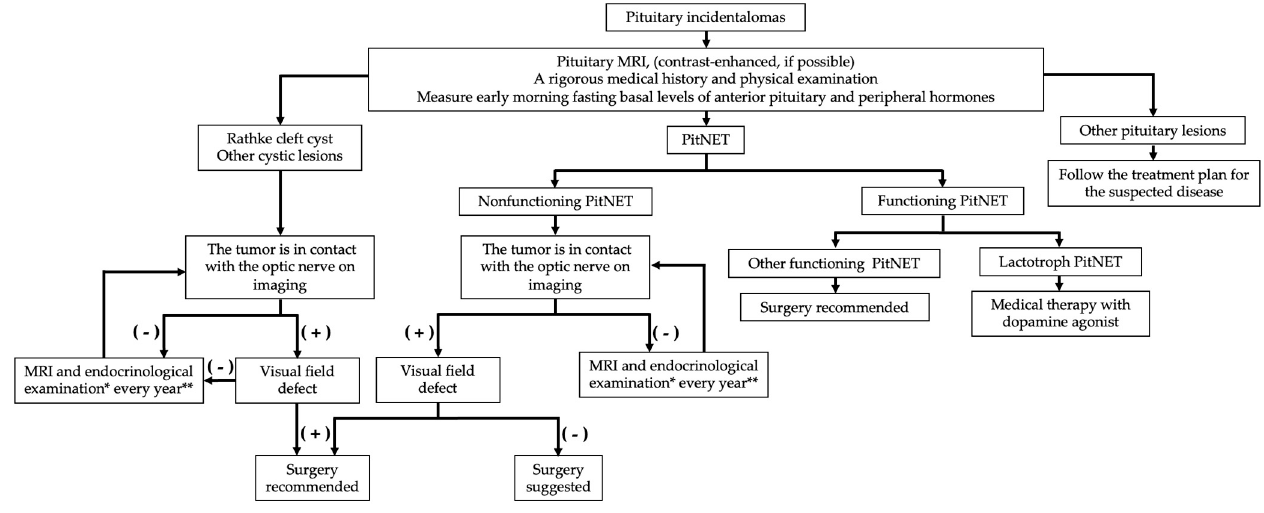
Figure 1. Our proposed scheme for the management of the pituitary incidentalomas. PitNET: pituitary neuroendocrine tumor. * Suggest surgery if there is progressive hypopituitarism. ** The first follow-up will be performed in half a year.